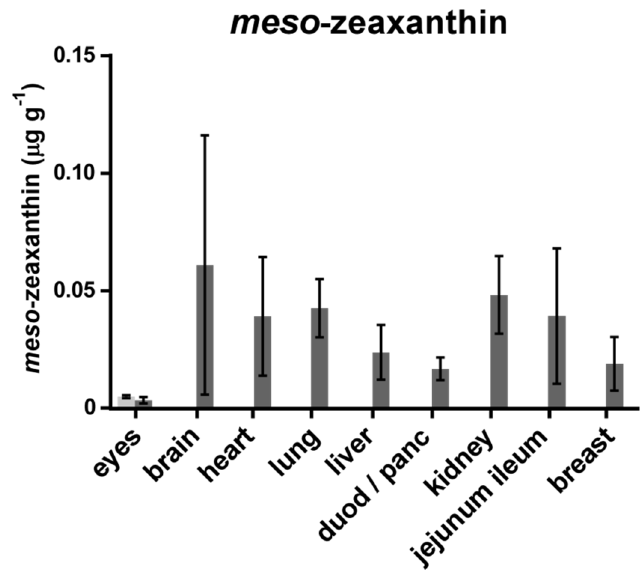
Figure 1. Meso ‐ zeaxanthin concentrations in organs of chicken fed a standard diet (control group, light grey), and chickens fed an L and MZ ‐ enriched diet (active group, dark grey).